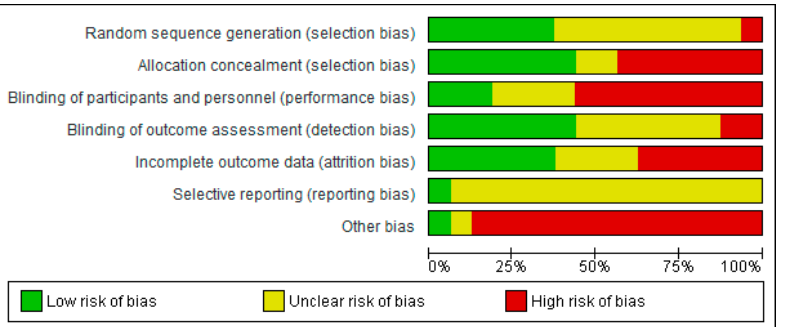
Figure 2. Review authors’ judgements about each risk of bias item presented as percentages across all included Randomised Controlled Trials. Insects 2021 , 12 , x FOR PEER REVIEW